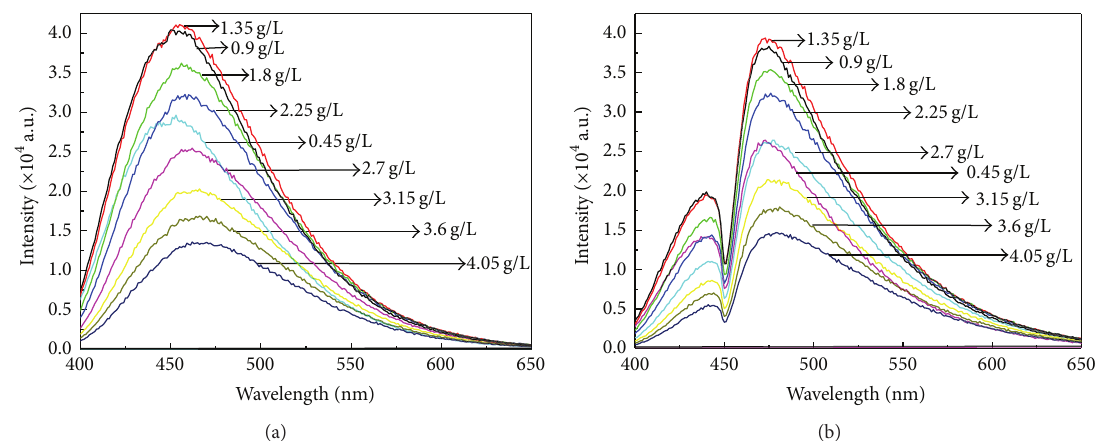
Figure 3: Polarization fluorescence spectra of vinegar-water solutions with different CH 3 COOH concentrations: (a) 0 ∘ and (b) 90 ∘ .